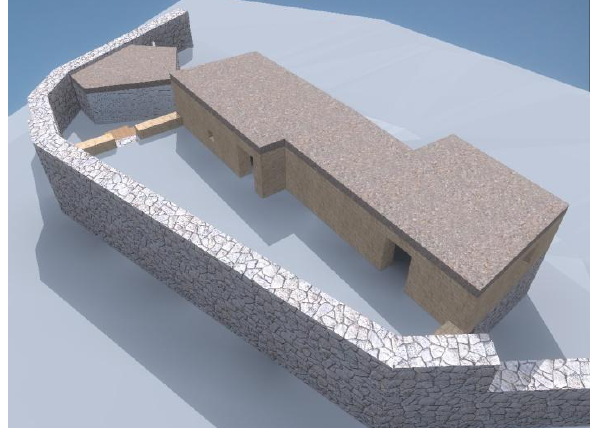
Figure 7. Agios Antonios Chomatas Site 9: ideal 3D reconstruction of the